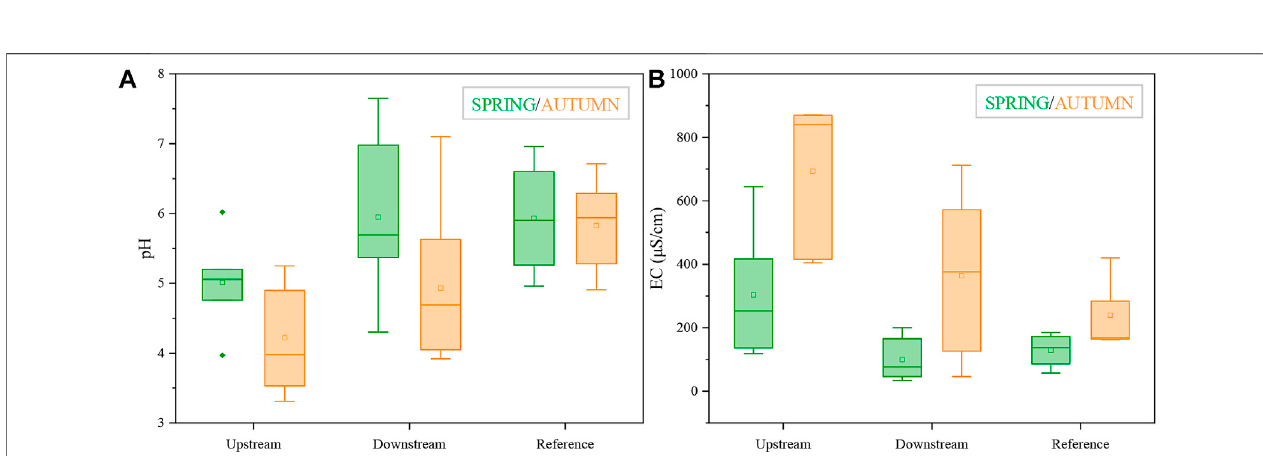
FIGURE 8 | (A,B) . pH and electrical conductivity (EC) values in the sediment from the Bystrzyca River at the studied measuring points.